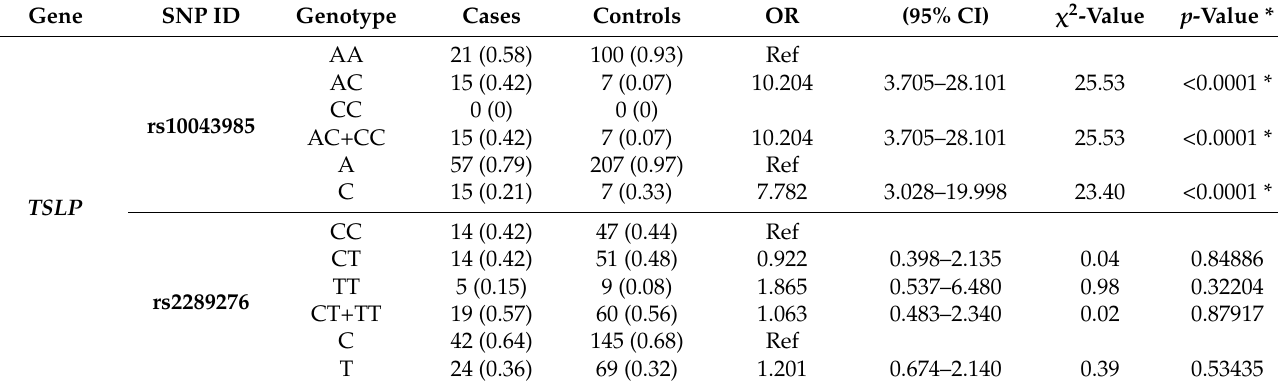
Table 10. Genotype frequencies of TSLP, TSLPR, and IL-7R gene polymorphisms in CRC and controls in rectal tumors. Gene SNP ID